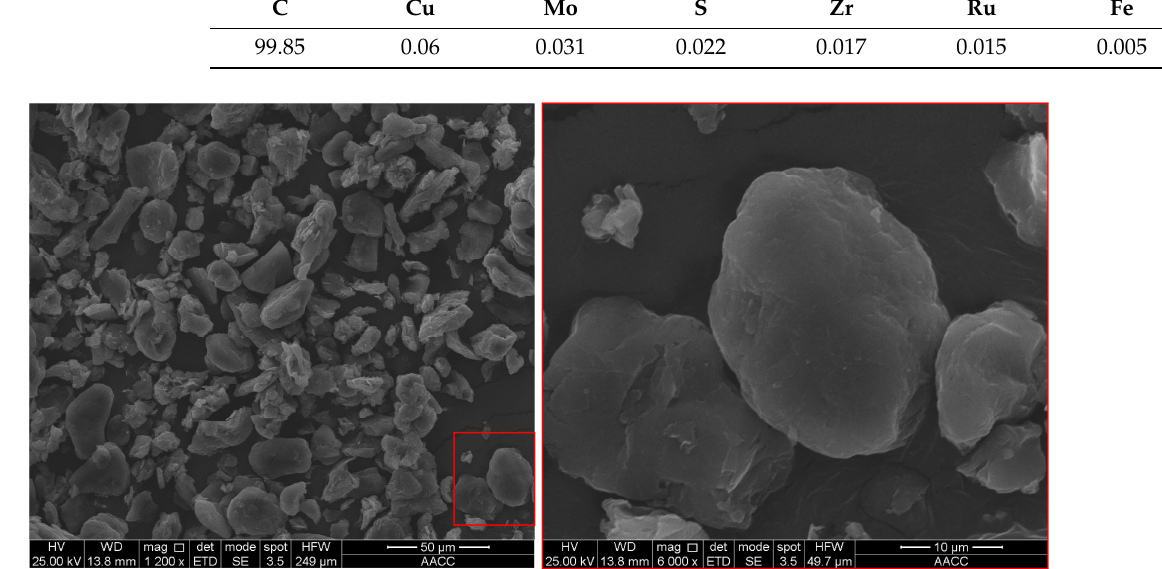
Figure 12. SEM image of the liberated graphite electrode material (the right image is an enlarged image of the red area).